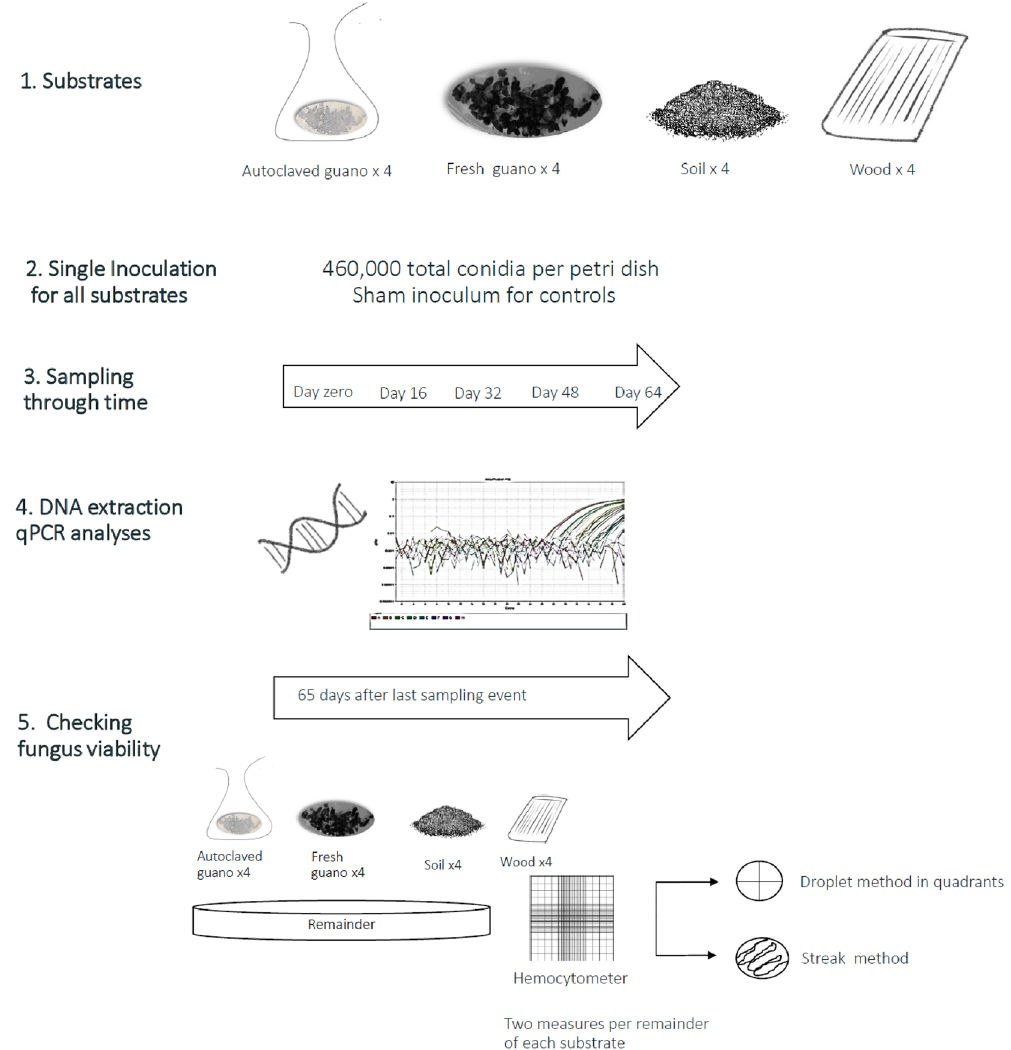
Figure 1. Graphic summary of the experimental design and methods we used during our